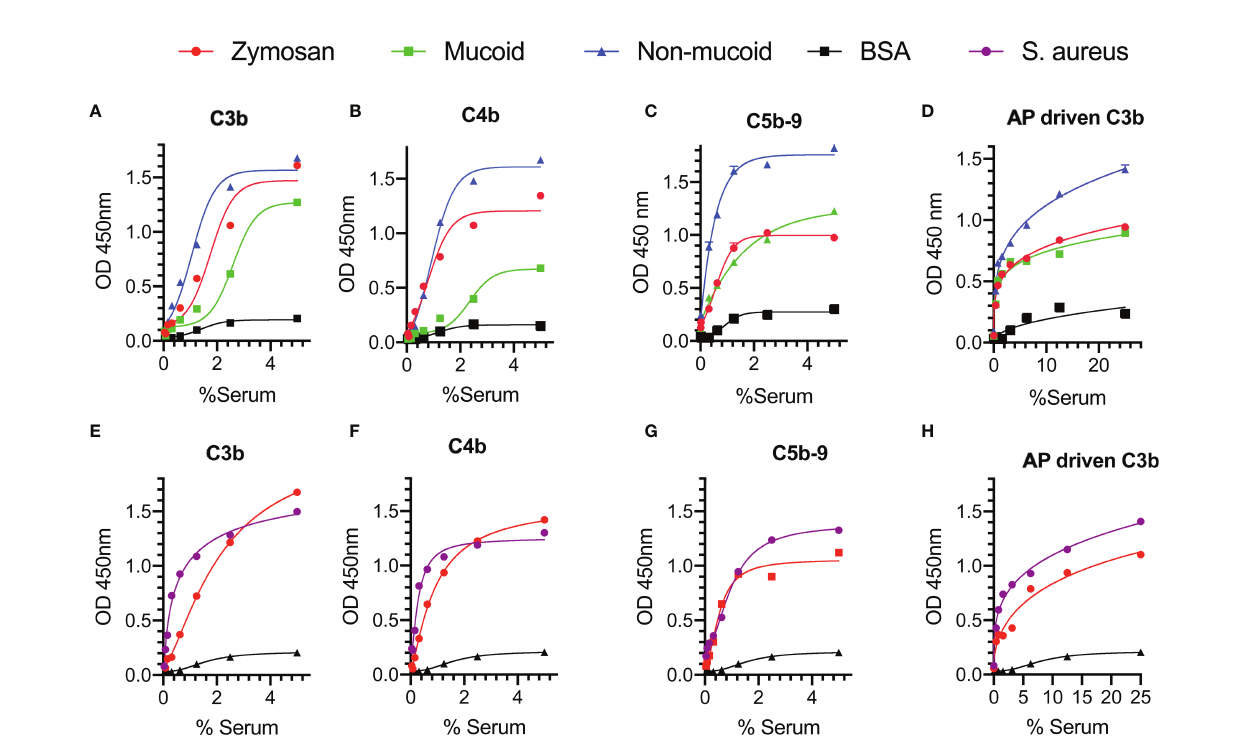
FIGURE 2 | Complement is activated on the surface of Klebsiella pneumoniae and Staphylococcus aureus . ELISA plates were coated with mucoid or non-mucoid strains of K. pneumoniae or with S. aureus . Wells coated with zymosan were used as a control. Plates were incubated with NHS in BBS with Ca +2 and Mg +2 (A – C, E – G) or EGTA buffer (D, H) . Complement C3b, C4b and C5b-9 deposition were detected using speci fi c antibodies. C3b, C4b and C5b-9 deposition were observed on the surface of K. pneumoniae (A – C) and S. aureus (E – G) in conditions permissive for both the CP and the LP pathways. High levels of C3b via the AP were also detected on the surface of the bacteria (D, H) . Results are means of duplicates ±